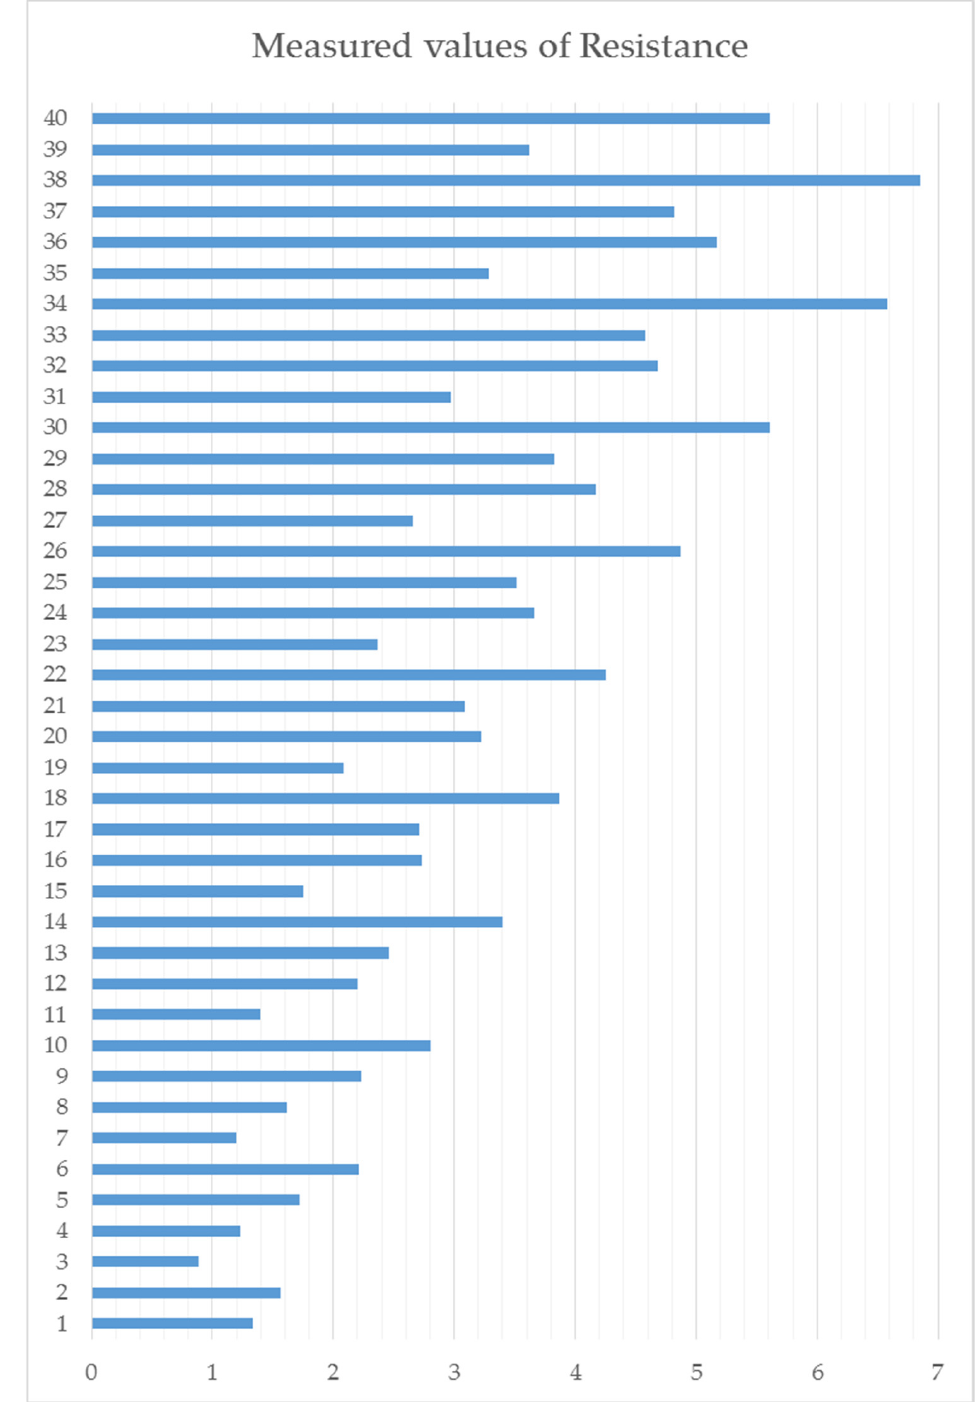
Figure 8. Presentation of measured electrical resistance.